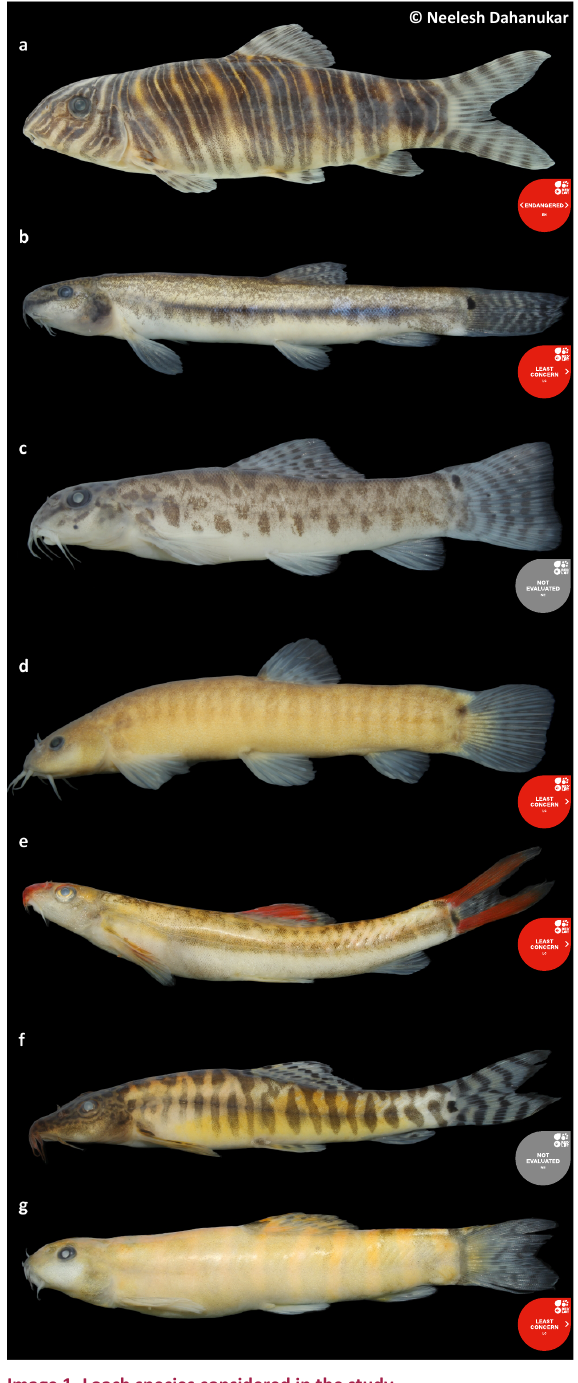
g - Schistura denisoni